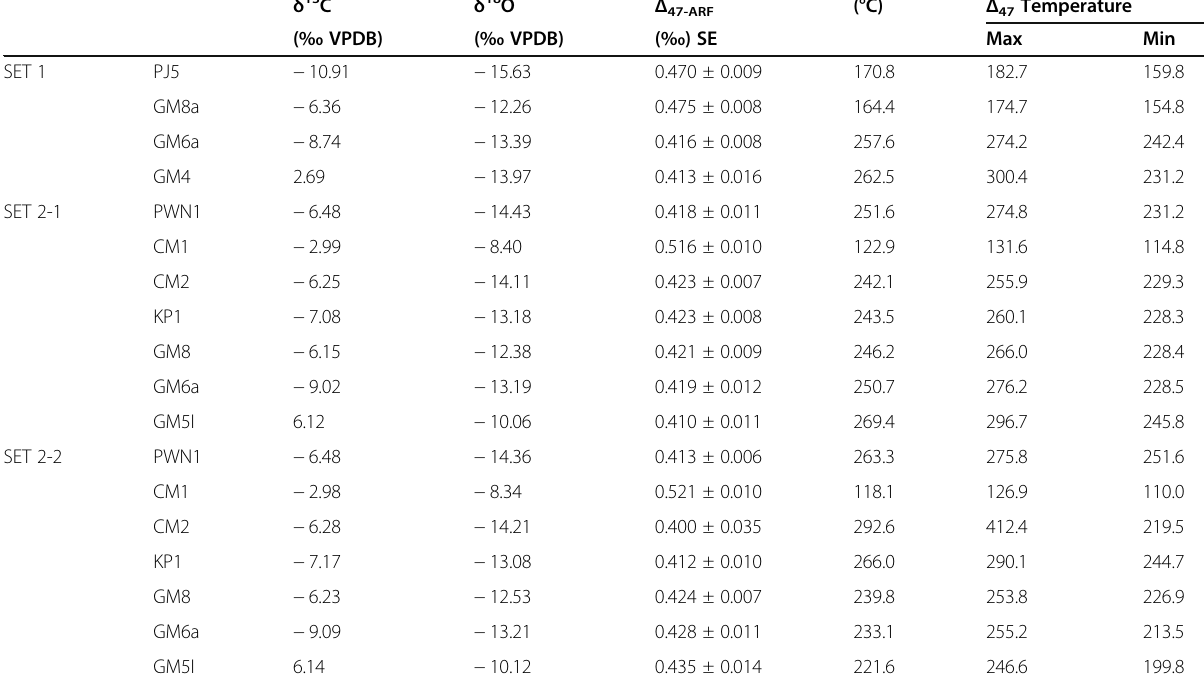
Table 1 Calcite clumped isotope temperatures of the samples. (Raw data of the analysis is in Supplementary Table